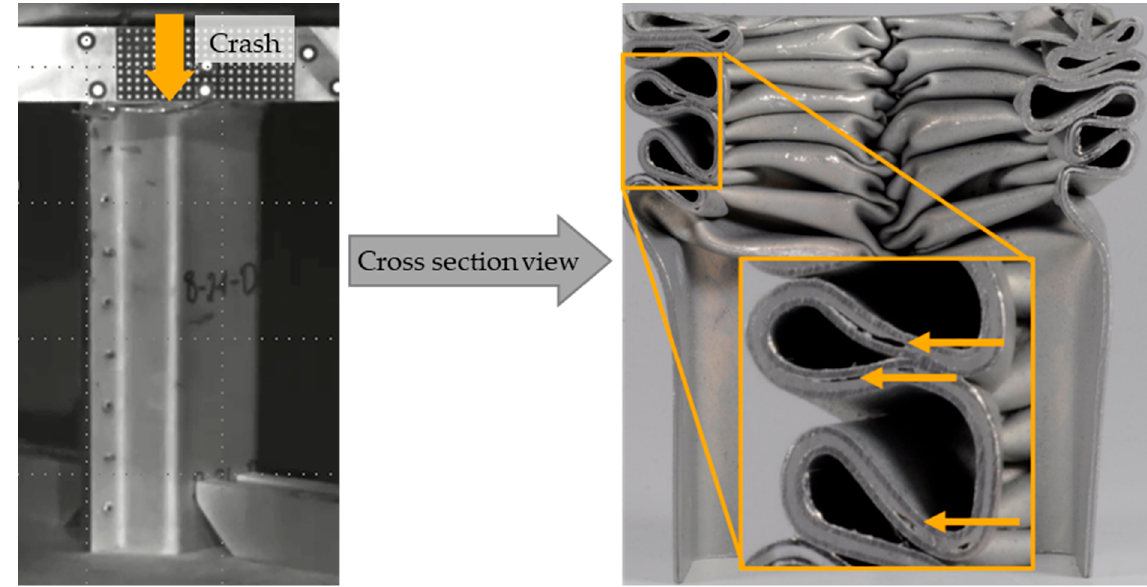
Figure 1. Adhesive failure in an MPM crashbox between polymer blend and steel sheet after a crash test.